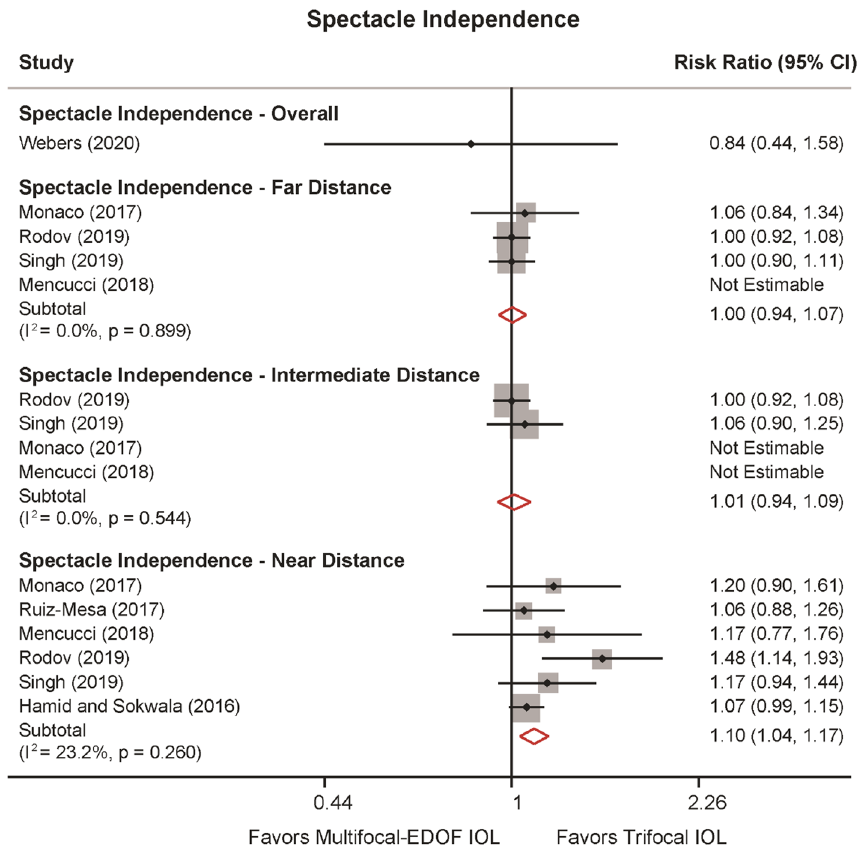
Figure 4. Spectacle independence of far, intermediate and near distance comparing trifocal and the hybrid multifocal-extended depth of focus (EDOF) intraocular lens